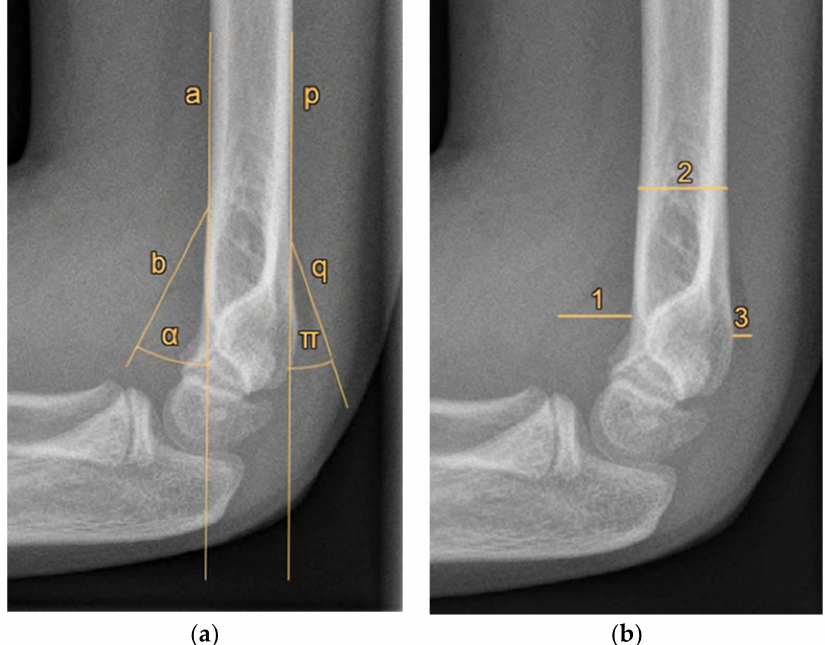
Figure 1. Radiographic measurements of the anterior and posterior fat pad signs. ( a ) Angle mea- surements. a: line along the anterior side of the humerus shaft; b: line indicating the anterior fat pad; α : angle measurement of the anterior fat pad; p: line along the posterior side of the humerus shaft; q: line indicating the posterior fat pad; π : angle measurement of the posterior fat pad. ( b ) Dis- tance measurements—1: maximum perpendicular distance of the anterior fat pad to the humerus; 2: humerus diameter measured at the proximal level of the anterior fat pad; 3: maximum perpendicu- lar distance of the posterior fat pad to the humerus. The anterior fat pad distance was indicated by 1 divided by 2; the posterior fat pad distance was indicated by 3 divided by